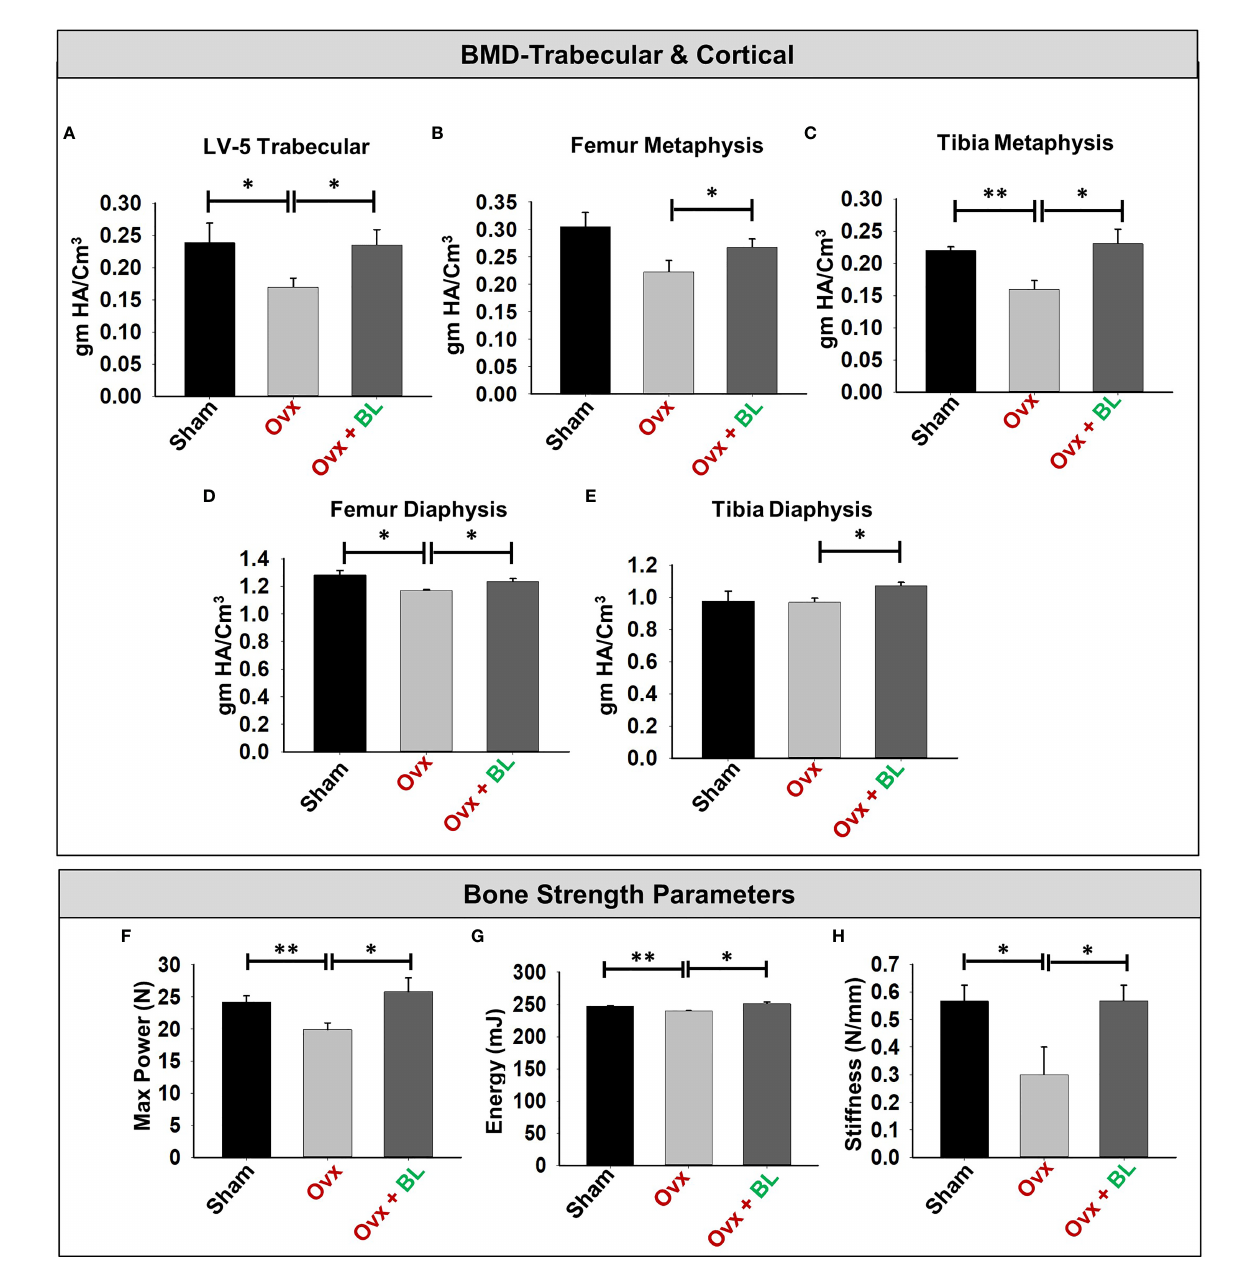
FIGURE 8 | BL administration enhances bone mineral density (BMD) and mechanical strength of bones. (A) Graphical presentation of BMD of the LV-5 trabecular region, (B) femur metaphysis, (C) tibia metaphysis, (D) femur diaphysis, and (E) tibia diaphysis. (F) Three-point bending test of femur diaphysis representing max power (N), (G) energy (mJ), and (H) stiffness (N/mm). Data are reported as mean ± SEM. Similar results were obtained in two independent experiments with n = 6. Statistical signi fi cance of each parameter was assessed by ANOVA followed by paired group comparison. *p < 0.05, **p < 0.01 compared with indicated